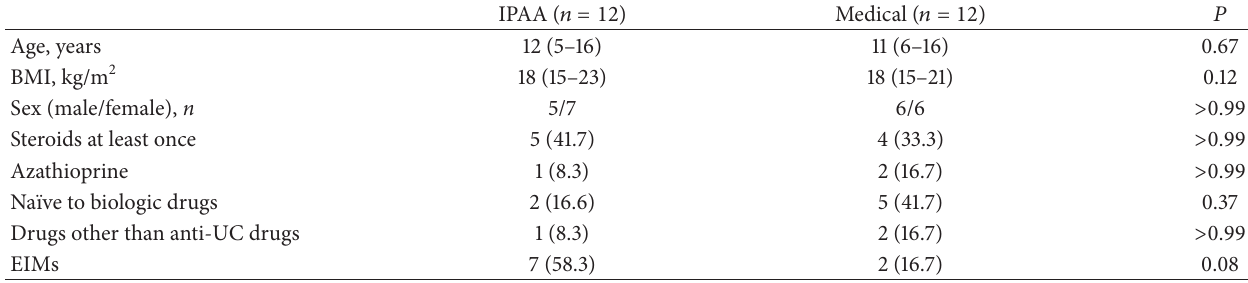
Table 3: Characteristics of patients in the childhood by treatment. Except where indicated otherwise, data are median (range) or n (%) values.